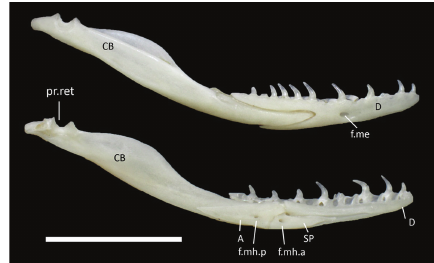
Figure 13: Mandible of Sordellina punctata (IBSP 22313). (a) Lateral and (b) medial view. Bar = 5 mm. Abbreviations other than in previous figures are a: angular; f.me: mentonian foramen; f.mh.a: anterior mylohyoid foramen; f.mh.p: posterior mylohyoid foramen pr.ret.: retroarticular process; sp: